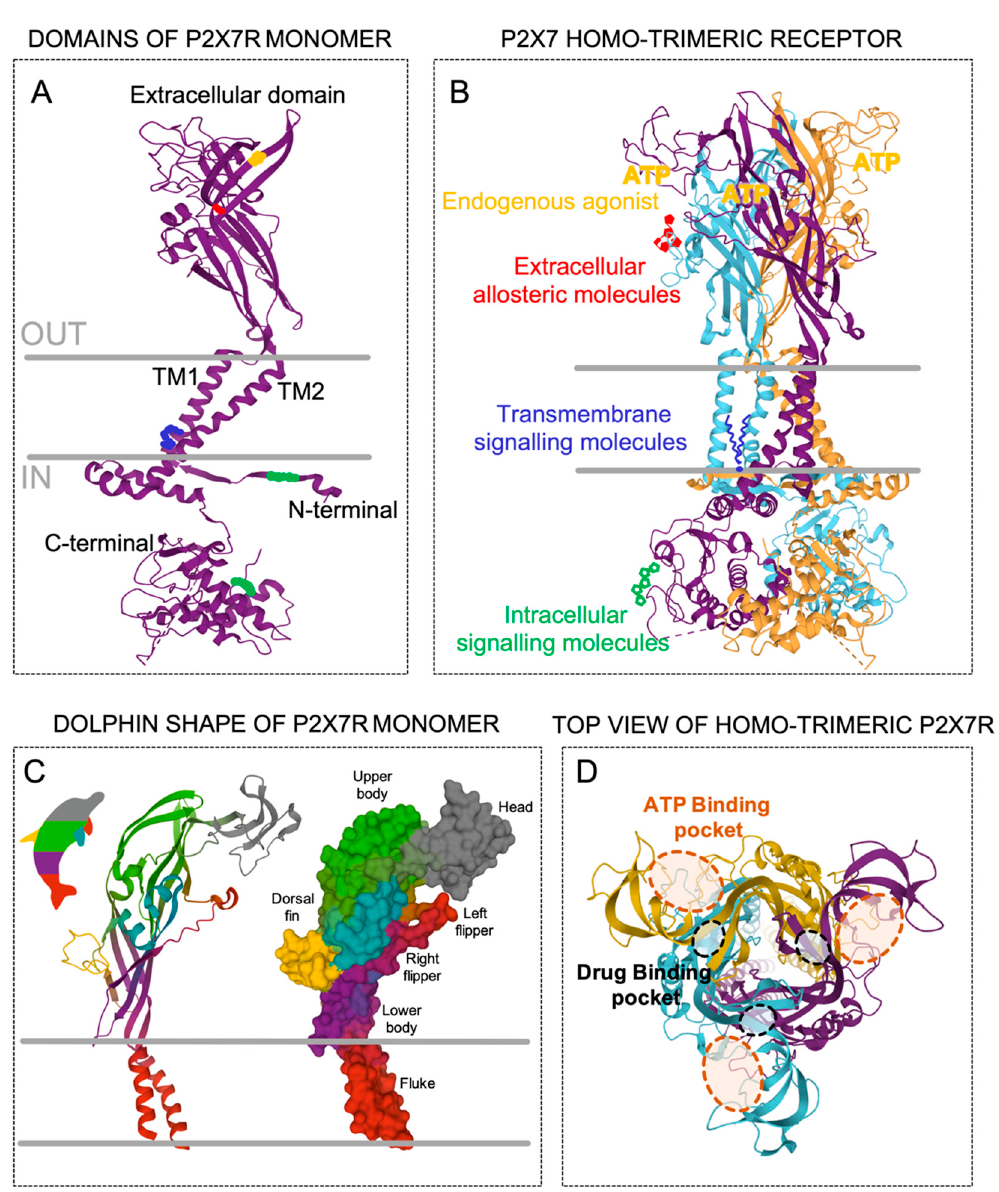
Figure 1. Topology of the P2X7 receptor (P2X7R). ( A ) Secondary structure of the P2X7R monomer with five domains; extracellular, transmembrane 1 (TM1), transmembrane 2 (TM2), intracellular N-termini, and intracellular C-termini. The colors into the domains represent possible specific molecular recognition sites. ( B ) Co-assembly of the three P2X7R monomers (purple, blue, and orange) position into the trimeric receptor showing possible surrounding molecules that could interact with the different domains, such as intracellular messengers at the N- and/or C- termini (green), membrane residues at the transmembrane domains (blue), and the endogenous agonist adenosine triphosphate (ATP, yellow) and/or other allosteric modulators (red) in the extracellular domain. ( C ) The P2X7 monomer represented as secondary structure (left) and molecular surface (right) styles resembling a dolphin. ( D ) Top view of the P2X7R structure embracing the three extracellular ATP-binding pockets (orange dashed lines) and the three additional drug-binding pockets (black dashed lines).